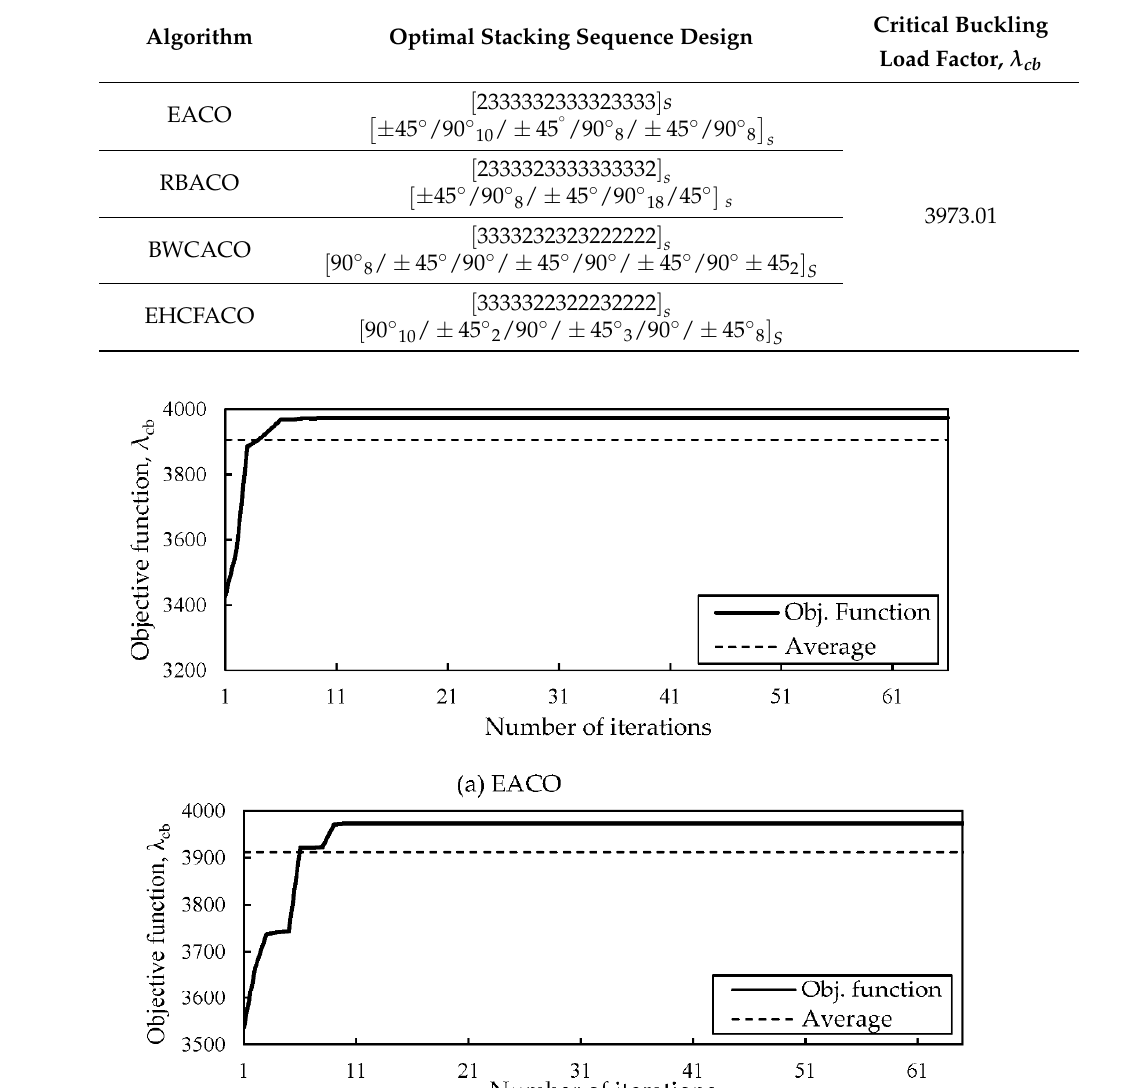
Table 4. The optimal stacking sequence for 64 ply laminates subjected to biaxial loading without